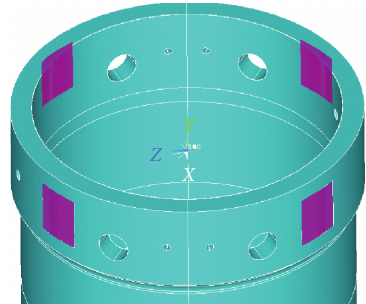
Figure 9: Double-T beams are shown in violet.